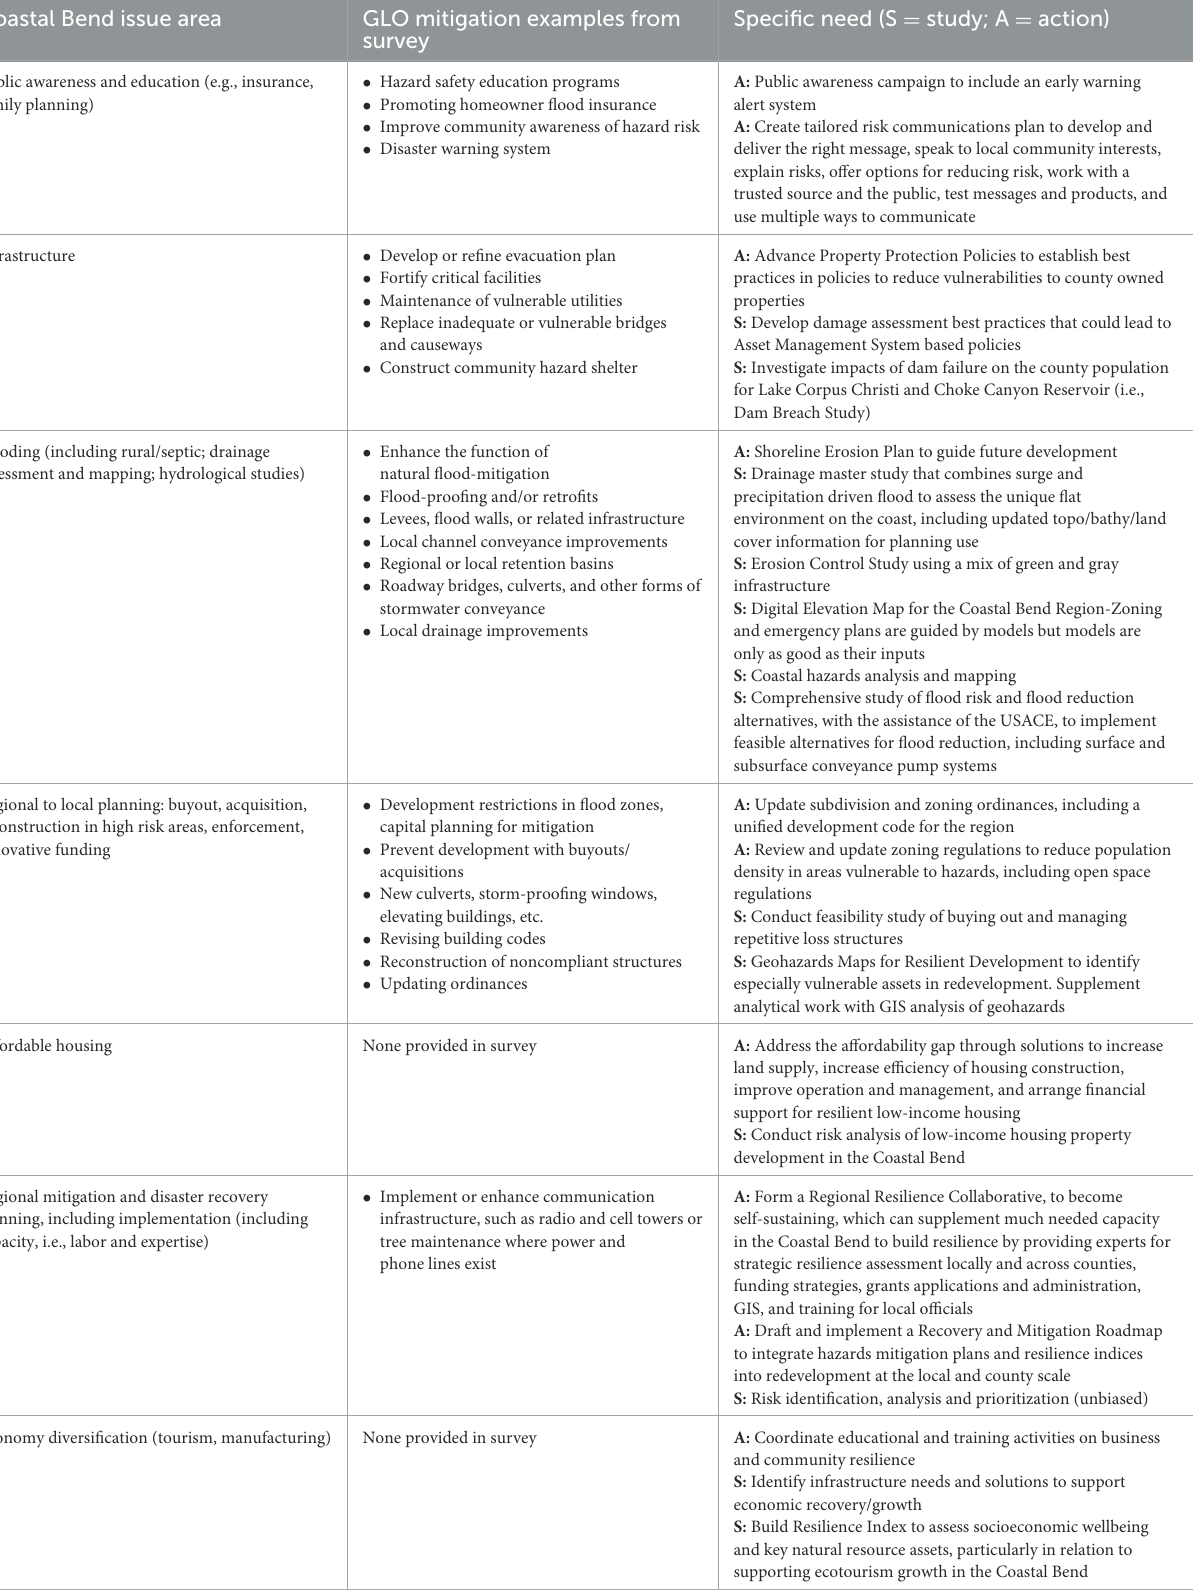
TABLE 1 Coastal Bend priority mitigation actions − 2019 GLO mitigation action plan survey. Coastal Bend issue